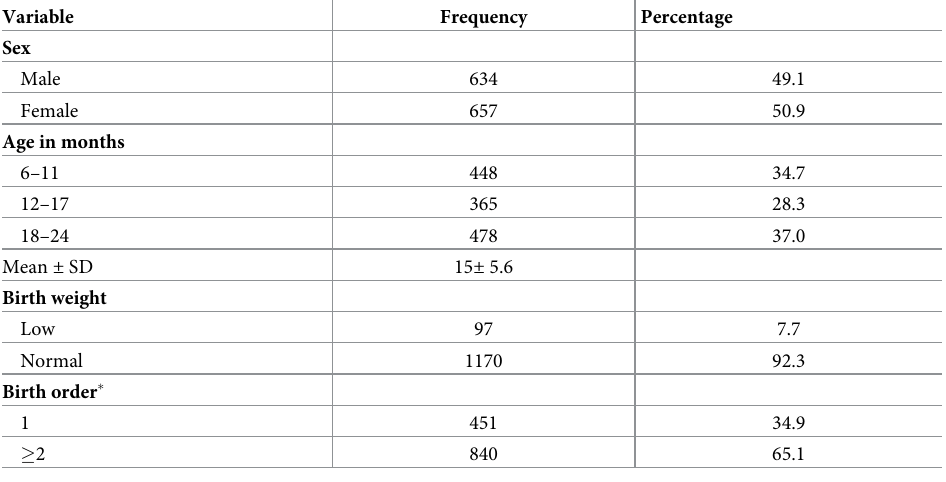
Table 2. Child background characteristics (N =